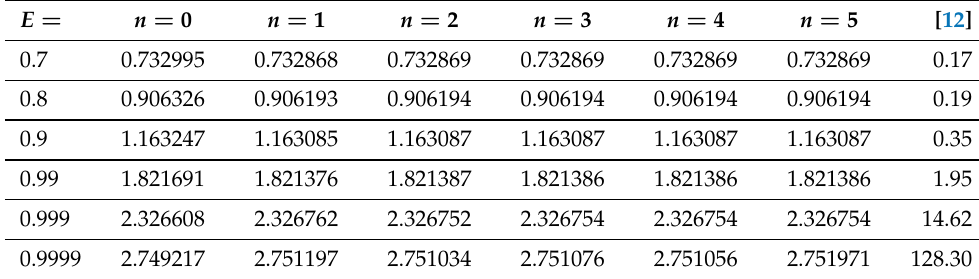
Table 2. Results for p = 2 and increasing values of n for values of E approaching E = 1. The last column shows the CPU time for 10 6 runs according to the algorithm proposed in [12] for the values of N , given in the last column of the table displayed in